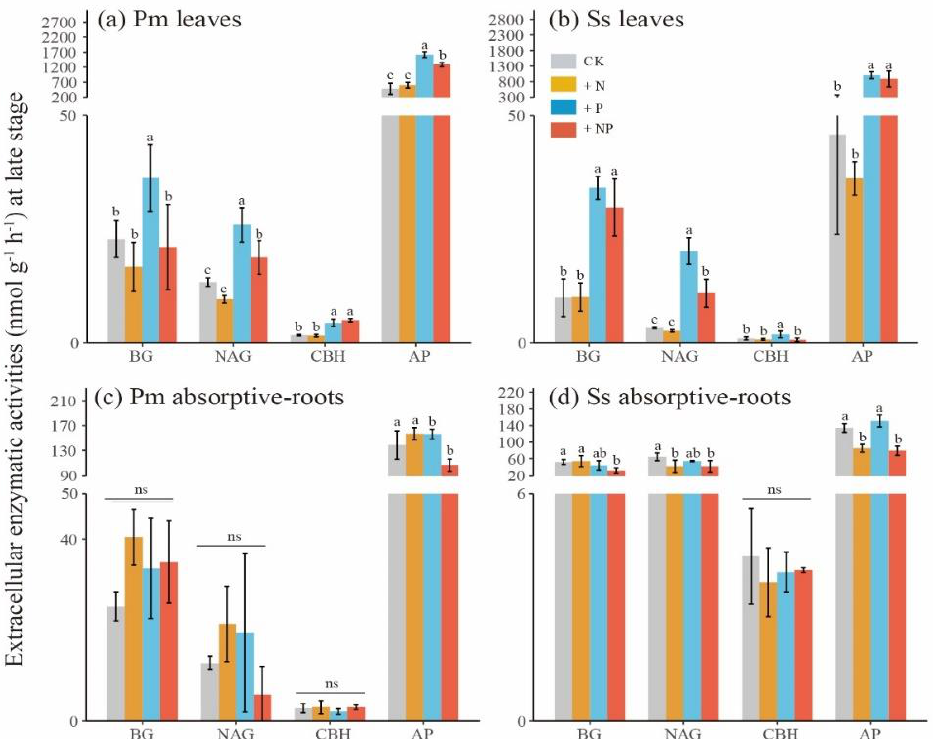
Figure 4. Activity of four microbial hydrolase extracellular enzymes in four substrates under differ- ent treatments in the 3-year stage of decomposition. Values are the mean ± SE ( n = 4). Significant differences between means were determined using Tukey’s honestly significant difference test. Dif- ferent letters indicate significant differences among treatments ( p < 0.05). CK, control; +N, nitrogen addition; +P, phosphorus addition; +NP, combined additions of nitrogen and phosphorus; BG, β -1,4- glucosidase; NAG, β -1,4-N-acetylglucosaminidase; CBH, cellobiohydrolase; AP, acid phosphatase; Pm, Pinus massoniana ; Ss, Schima superba